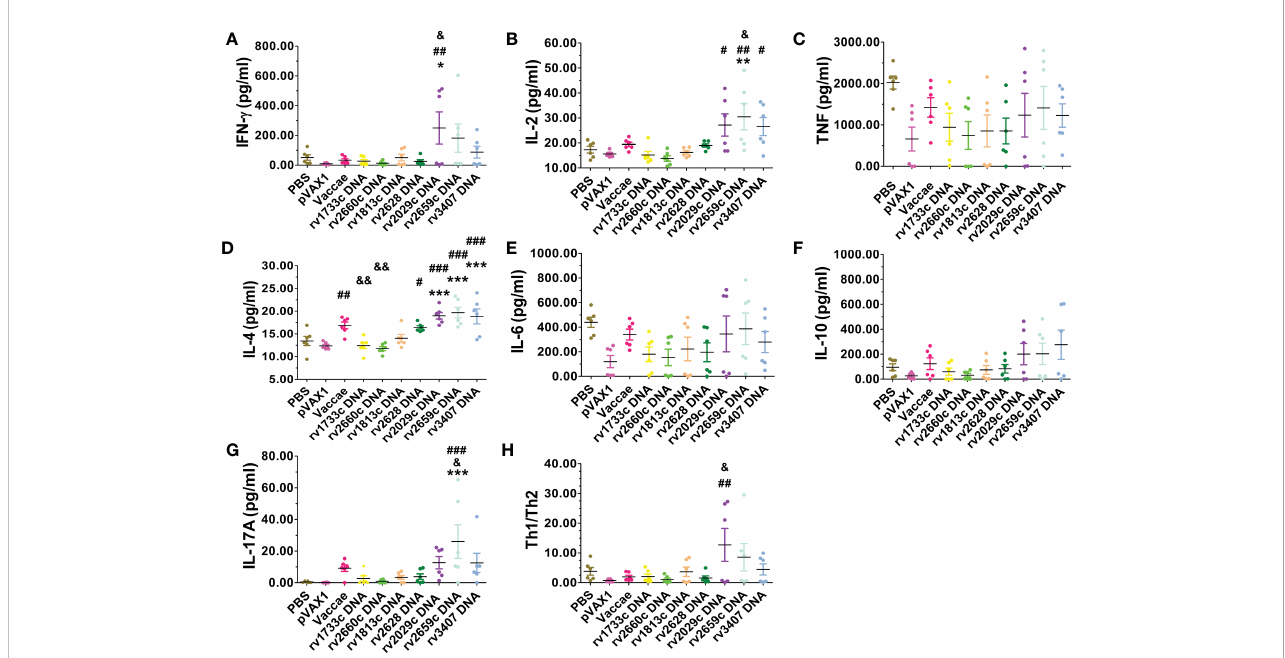
FIGURE 7 The levels of IFN- g , IL-2, TNF- a , IL-4, IL-6, IL-10 and IL-17A cytokines in the splenocyte culture supernatant in response to recombinant mixed latency- related proteins for 72hrs were detected with a Mouse Th1/Th2/Th17 Cytokine Kit. (A) IFN- g (pg/ml), (B) IL-2 (pg/ml), (C) TNF (pg/ml), (D) IL-4 (pg/ml), (E) IL-6 (pg/ml), (F) IL-10 (pg/ml), (G) IL-17A (pg/ml), (H) Th1/Th2. Compared with PBS group: * P < 0.05, ** P < 0.01, *** P < 0.0001; Compared with vector group: # P < 0.05, ## P < 0.01, ### P < 0.0001; Compared with Vaccae vaccine group: & P < 0.05, && P <